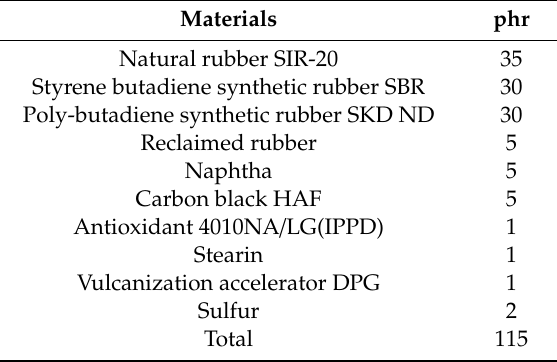
Table 1. The rubber structure around the metal insertion.